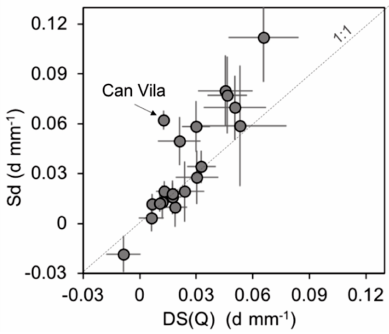
Figure 4. Comparison of discharge sensitivities DS( Q ) and S d for 20 Swiss catchments and Can Vila (excluding Aach and Mentue for which unrealistic values for DS( Q ) or S d were obtained). Error bars indicate ± 1 standard error.